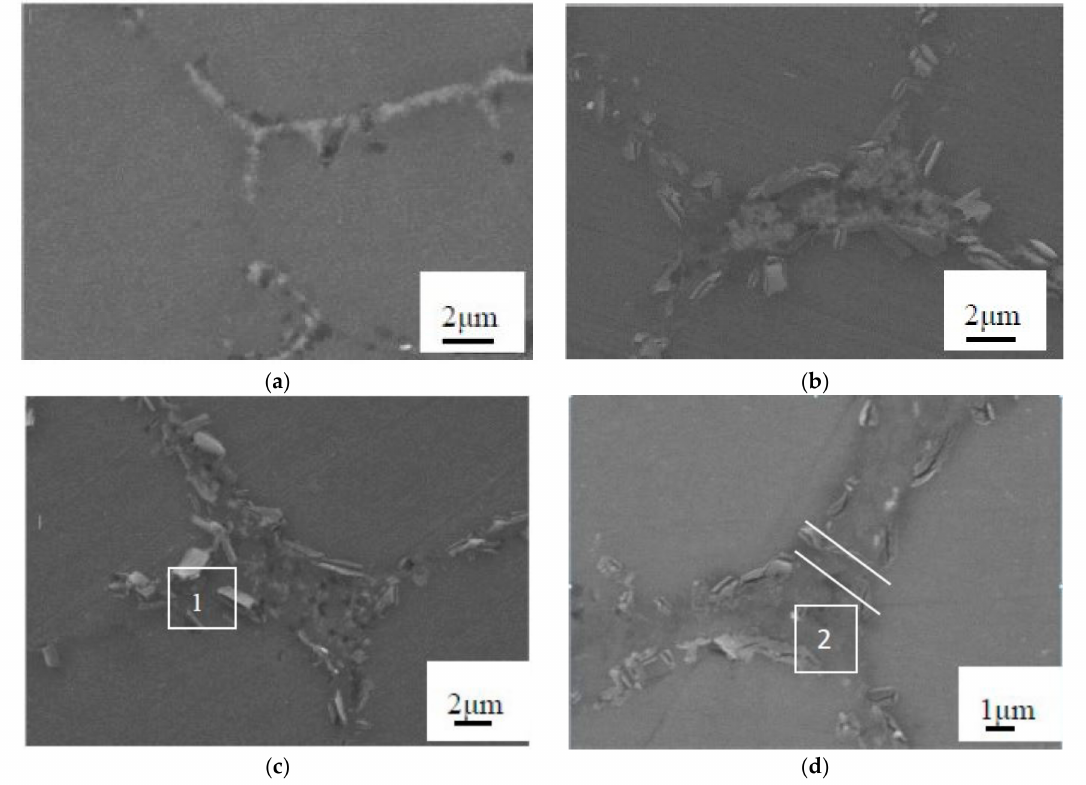
Figure 4. SEM micrographs of AA6061 / N-SiC composites sintered at 550 ◦ C with 3 ( a ), 5 ( b ), 10 ( c ) and 15 ( d ) vol.%